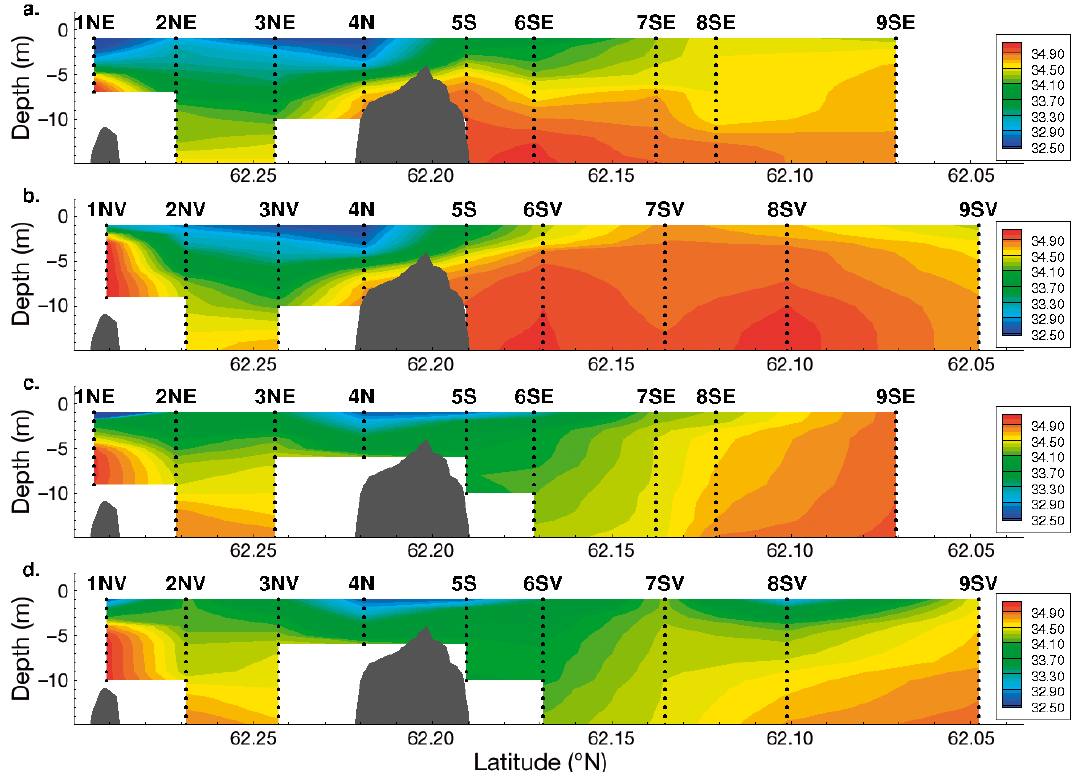
Fig. 4. Salinity in the upper 15 m of the water column during the spatial surveys in (a,b) November 2013 and (c,d) February 2014. Grey area: bottom depth at the 2 shallow sills separating the northern basin from the open ocean (left grey area), and the southern from the northern basin (middle grey area). Stations are as in Fig.